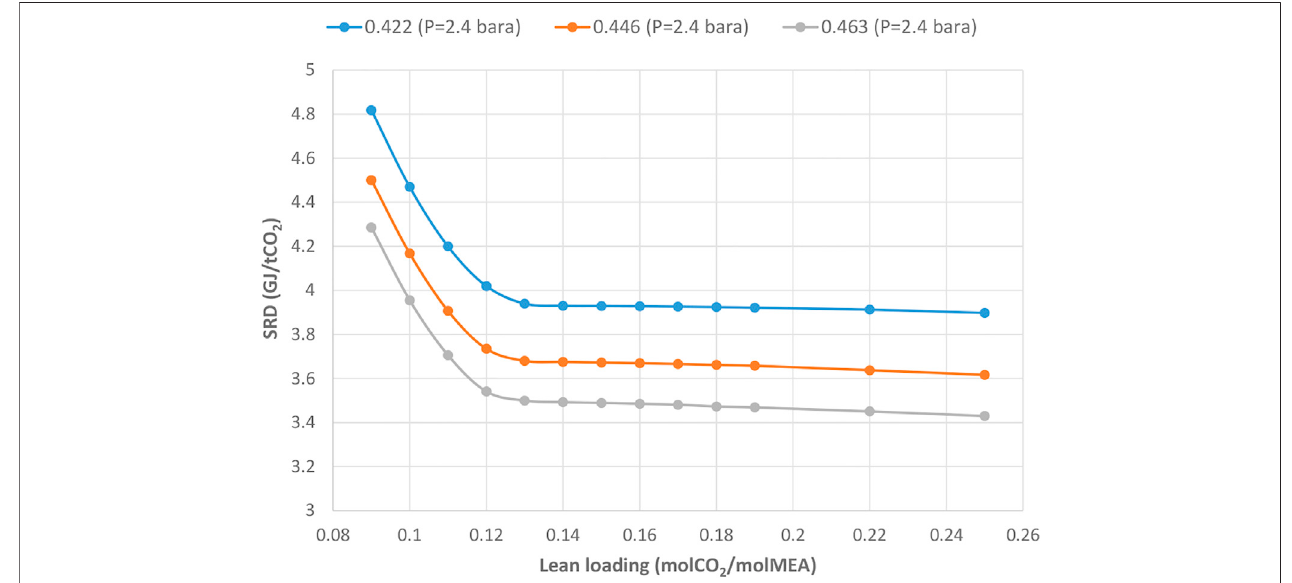
FIGURE2| Effect ofleanloading onthe speci fi creboiler dutyfor differentrich loadingsof0.422,0.446,and 0.463 molCO 2 /molMEA (allat aconstantCO 2 capture level of 95%, corresponding to a capture rate of 39.985 kg/s).